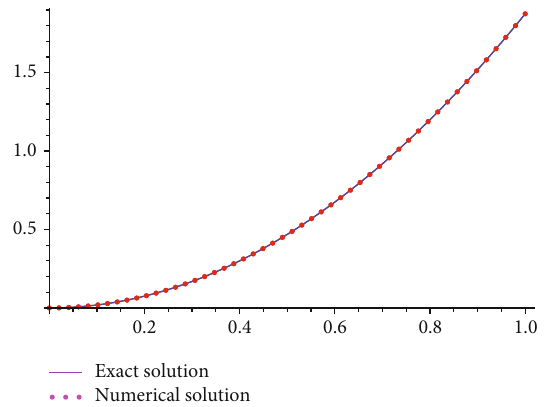
Table 5: Comparison of the numerical result of u